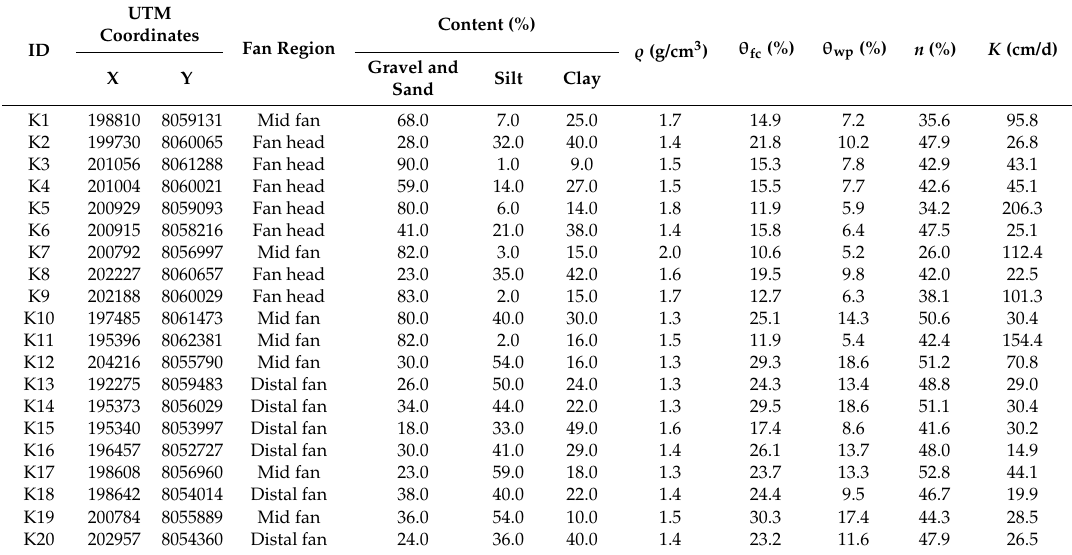
Table 3. Location and physical properties of the top soil samples collected in the Punata alluvial fan.